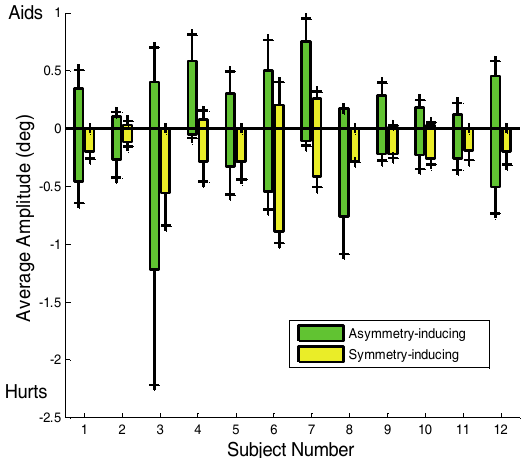
Figure 11 Plot of average enhancement of the vergence response by an asymmetry-inducing and symmetry-inducing saccade. Positive values indicate enhancements that increase convergence, negative values decrease